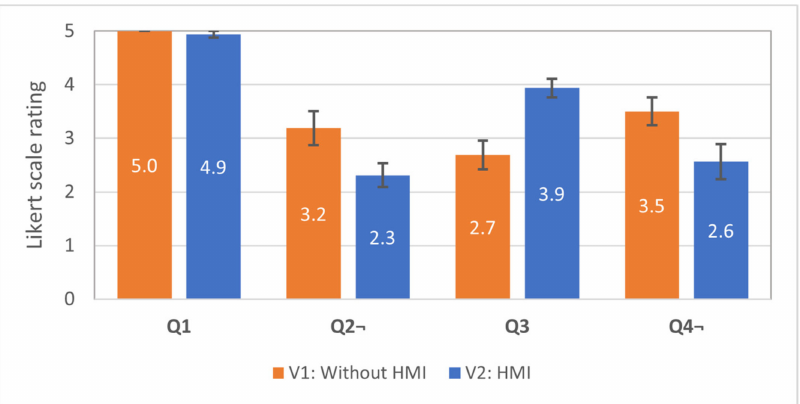
Figure 17. Average scores with standard errors for the questions Q1–Q4 used in the user studies (16 participants). Score 5 denotes “totally agree” and 1—“totally disagree”. Questions Q1, Q3 —higher is better; Q2, Q4—lower is